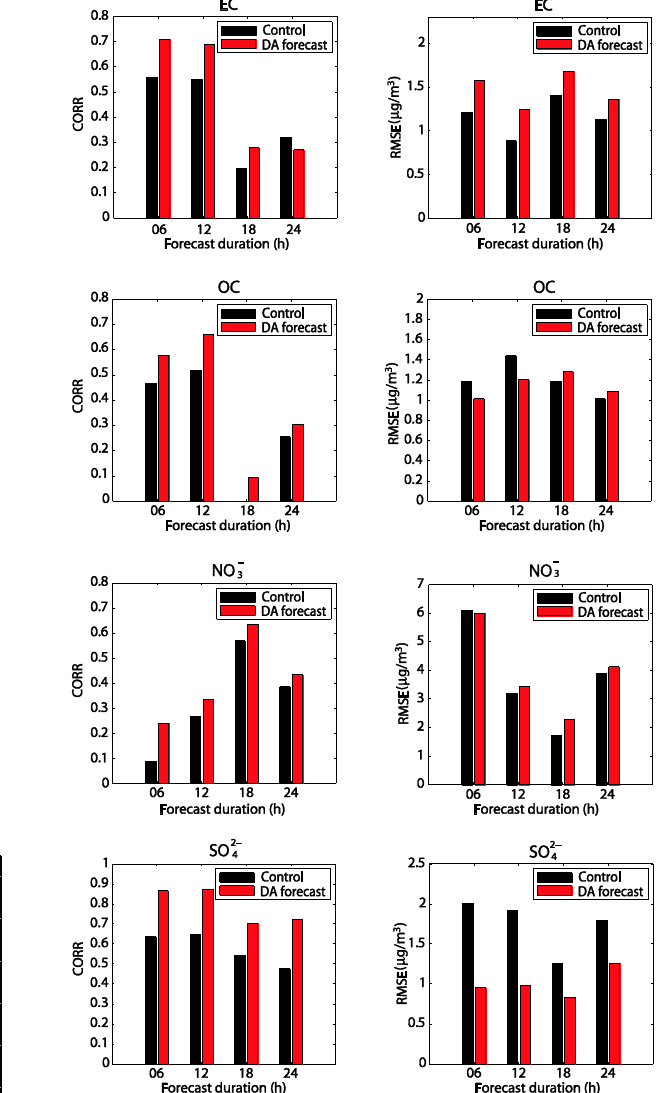
Figure 9. Correlations (left) and root-mean square errors (RMSEs in µg/m 3 ) (right) of the Fig. 9. Correlations (left) and root-mean-square errors (RMSEs in µgm − 3 ) (right) of the species concentration forecasts against obser- specie concentration forecasts against observations as a function of forecast duration. The vations as a function of forecast duration. The forecast is initialised forecast is initialized at 12 UTC. Both correlations and RMSEs are calculated against the at 12:00UTC. Both correlations and RMSEs are calculated against the observations from 42 stations during the period 12:00UTC, observations from 42 stations during the period 12 UTC, 5 May to 12 UTC, 14 June, 2010. Fig. 8. Spatial distribution of RMSEs of the 24h forecasts. 5 May to 12:00UTC, 14 June 2010. The black bars for the control Figure 8. Spatial distribution of RMSEs of the 24 h forecasts. (a) shows the RMSEs of (a) shows the RMSEs of the control forecast, and (b) the RMSEs of forecast without data assimilation, and the red bars for the forecast The black bars for the control forecast without data assimilation, and the red bars for the the 24h forecast with data assimilation. The RMSE difference be- with data tween the control and 24h forecast with data assimilation is shown forecast with data assimilation. the control forecast, and (b) the RMSEs of the 24 h forecast with data assimilation. The in the panel (c) , in which a negative value indicates a decrease of RMSE arising from data assimilation. The RMSEs are in µgm − 3 . RMSE difference between the control and 24 h forecast with data assimilation is shown in the panel (c), in which a negative value indicates a decrease of RMSE arising from data assimilation. The RMSEs are in g/m 3 .